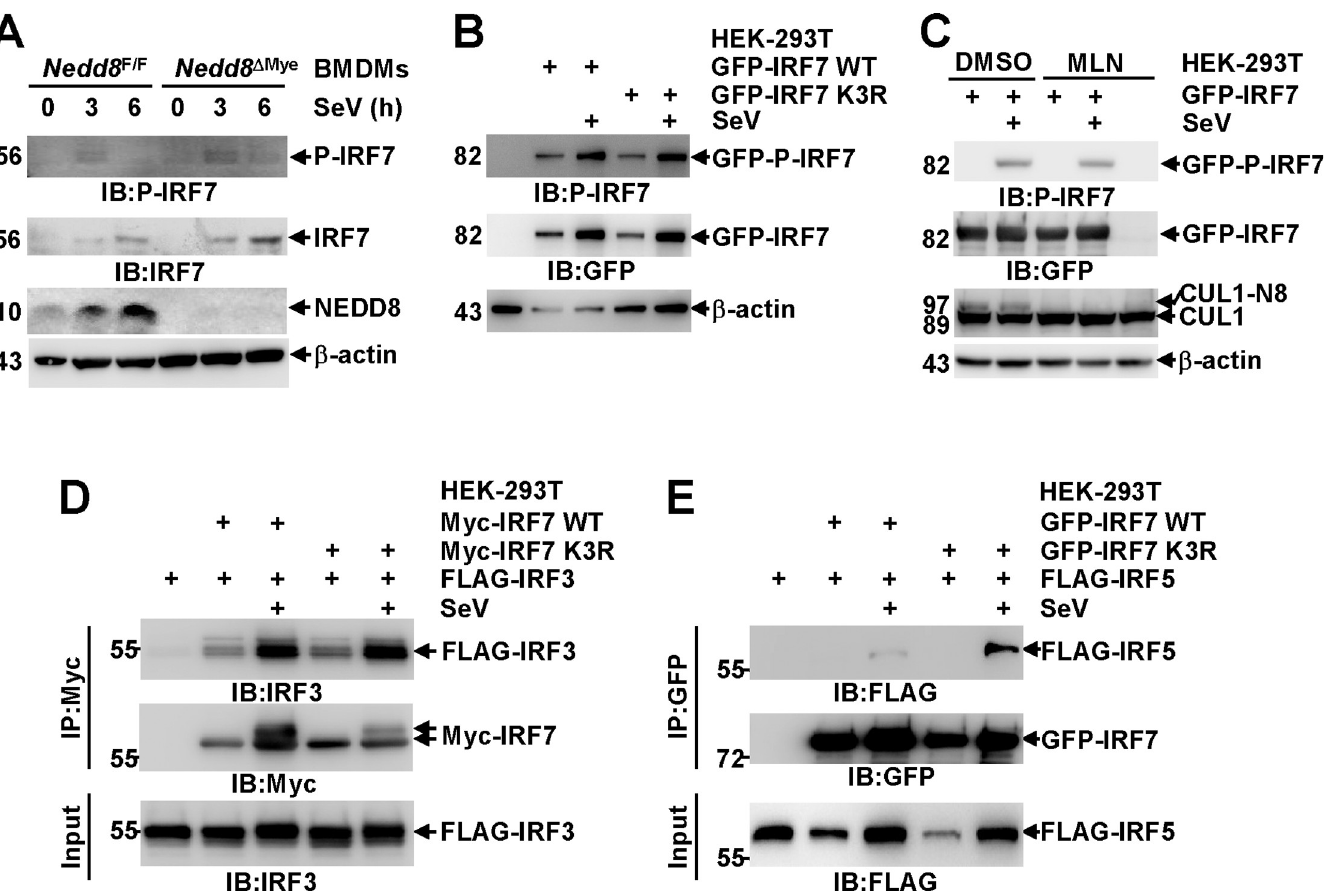
Fig 7. The neddylation of mammalian IRF7 prevents its dimerization with IRF5. (A-C) After BMDMs were cultured from Nedd8 F/F and Nedd8 Δ Mye mice or 24 h after HEK-293T cells were transfected with the indicated mammalian expression vectors, the cells were pretreated with or without MLN4924 (0.5 μ M, 3 h), followed by SeV infection for various periods of time as indicated. Then the phosphorylation and expression of murine IRF7 was detected by IB with the indicated antibodies. P-IRF7, phosphorylated IRF7 at Ser437/438. (D, E) Twenty-four hours after HEK-293T cells were transfected with the indicated mammalian expression vectors, the cells were infected with SeV for 6 h or left untreated. Then the interaction between exogenous murine IRF7 and exogenous human IRF3 (D) or exogenous human IRF5 (E) was determined by Co-IP.